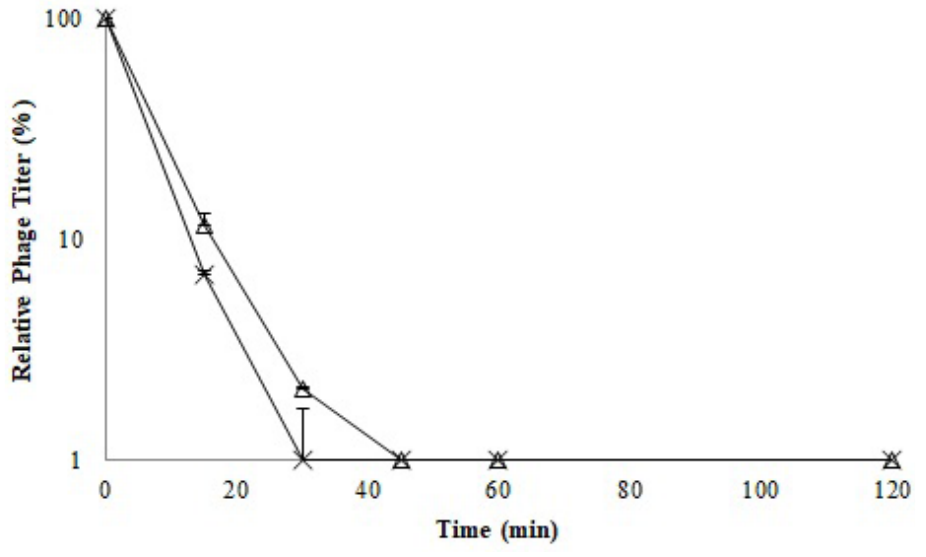
Figure 6: Effect of ultraviolet irradiation on viability of the B . cereus bacteriophages BaceFT01 (Δ) and BaceCM02